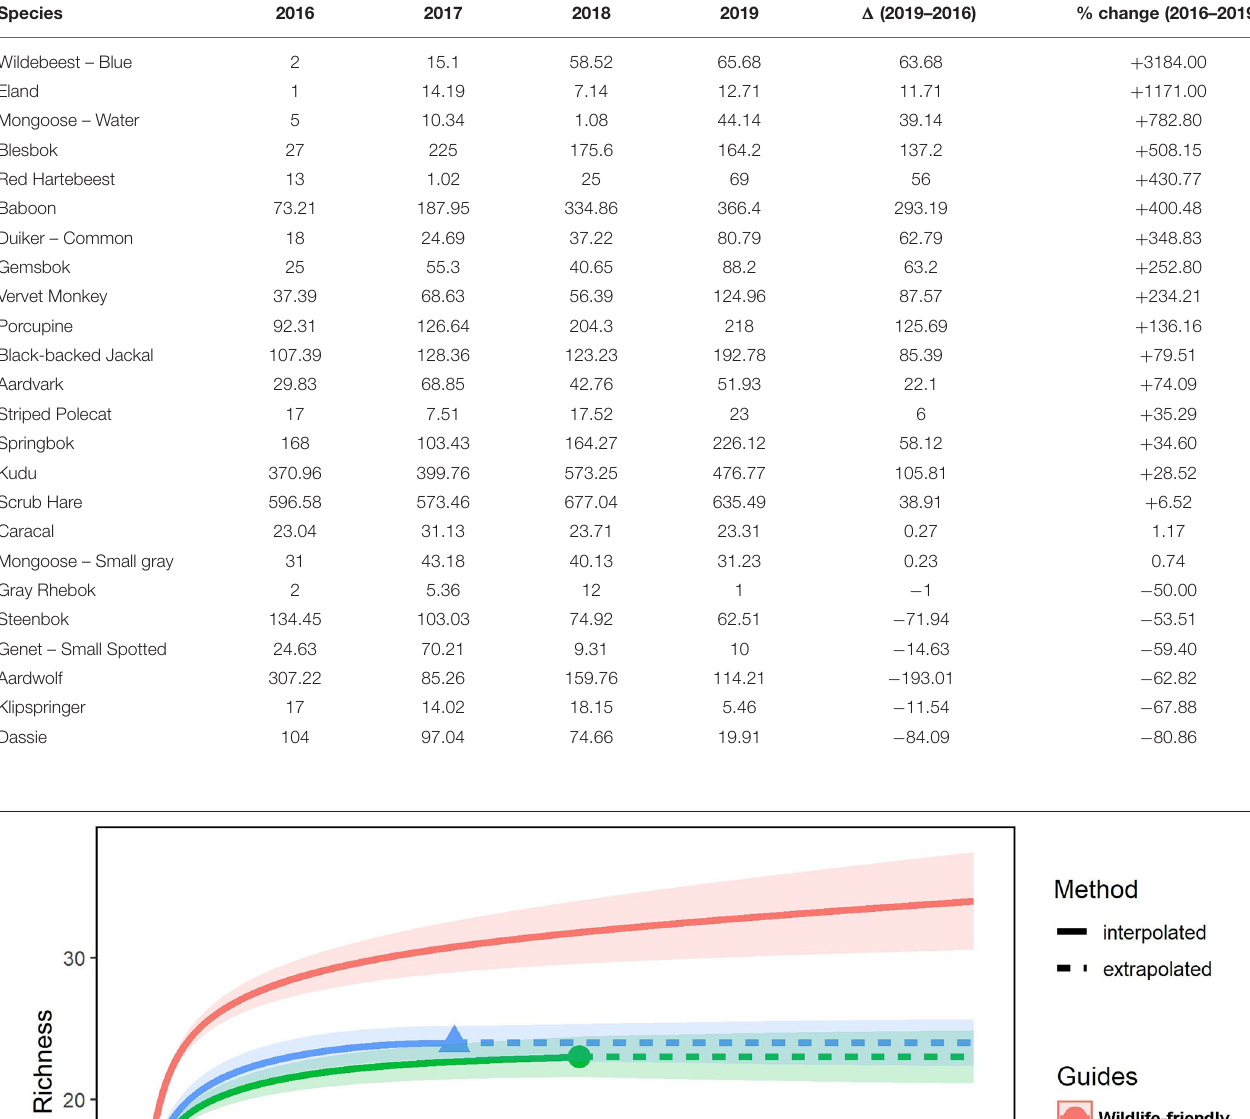
TABLE 3 | Relative Abundance Index (RAI) of species that occurred in all 4 years on all 16 cameras retained on the wildlife-friendly farm. Species